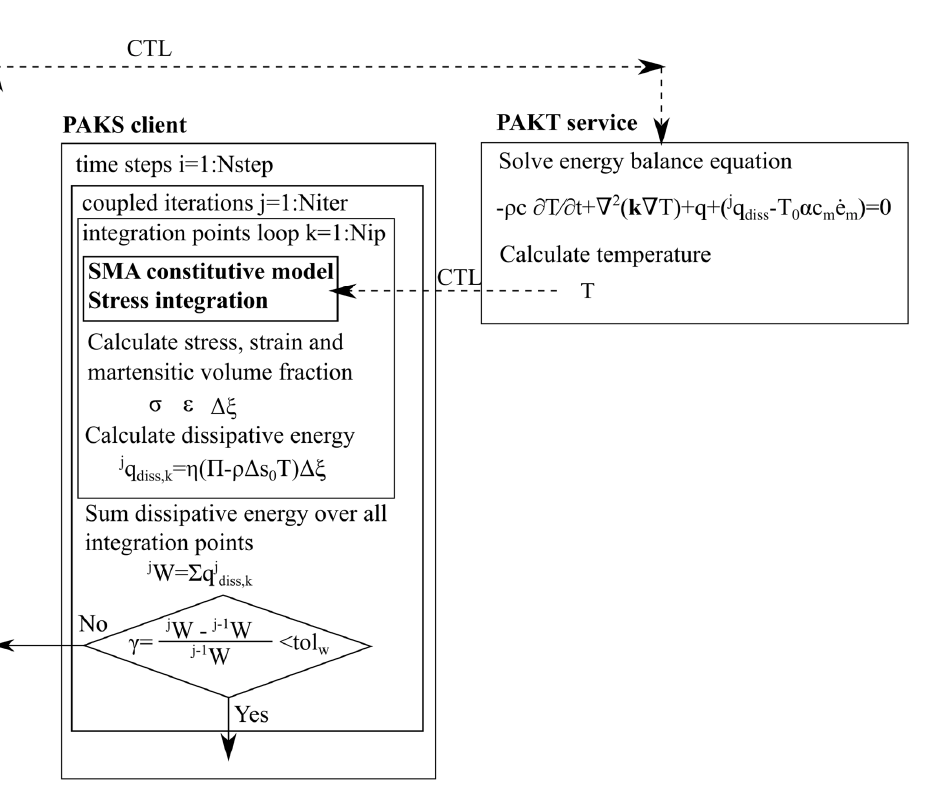
Figure 3. Scheme of the iterative procedure for thermo-mechanical coupling analysis.